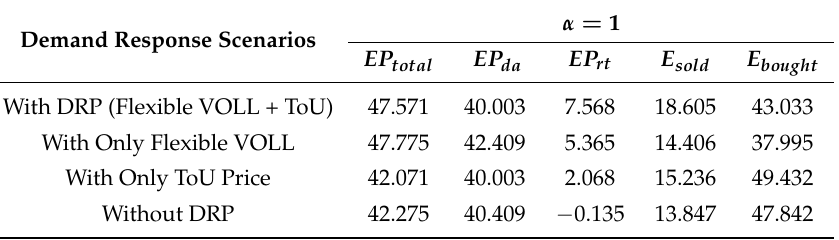
Table 4. Impact of demand response program on the amount of expected profit of the system and sold/bought electrical energy to/from the local electricity market. DRP, Demand Response